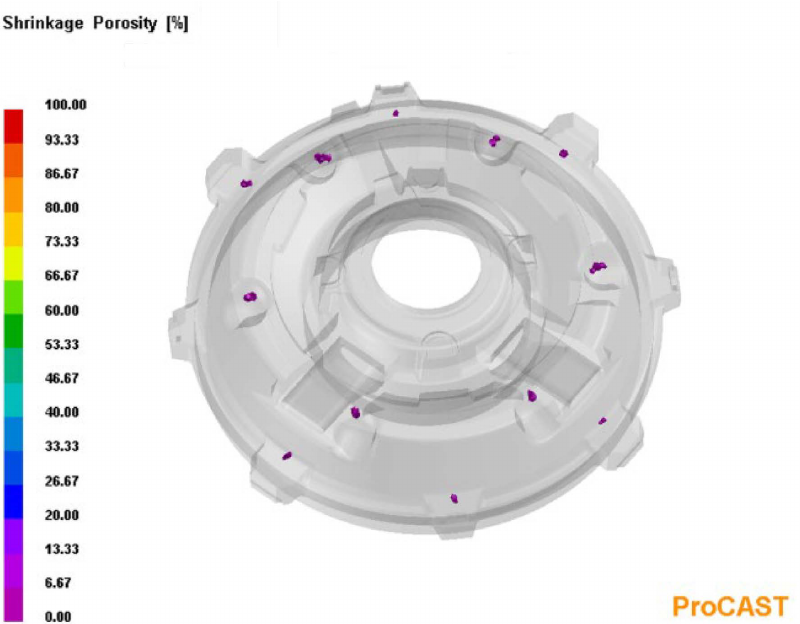
Figure 11. Distribution of microporosity in casting with small number of nucleation sites of pri- mary